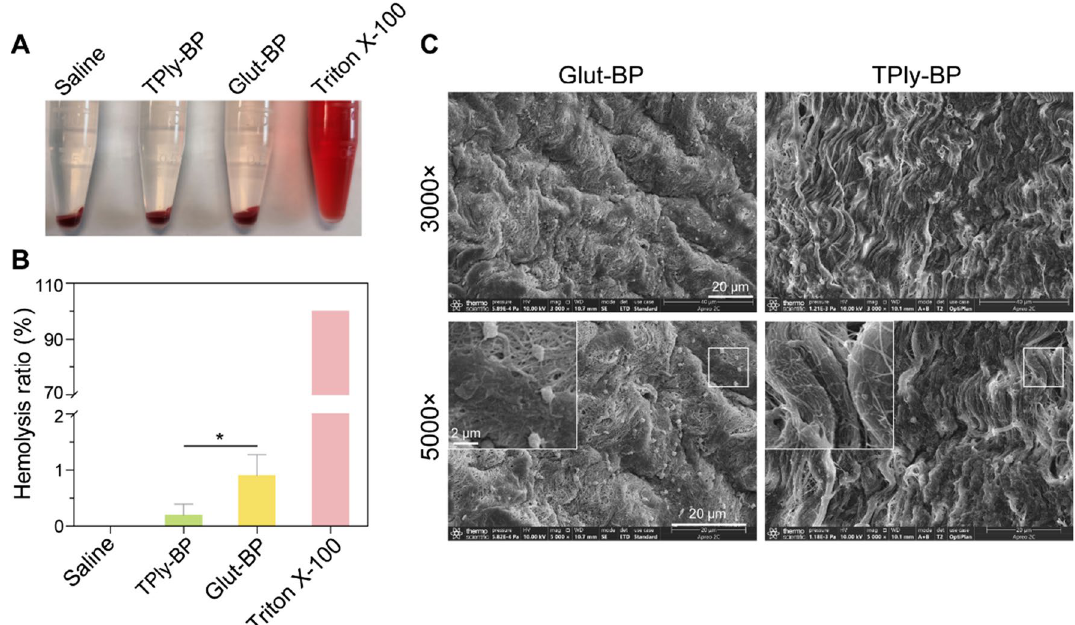
Fig. 5 Blood compatibility study of Glut-BP and TPly-BP. A Photograph of centrifuged red blood cell diluent after incubation with Glut-BP and TPly-BP at 37 °C for 1 h. B The hemolysis ratio of Glut-BP and TPly-BP (n magnifications (3000 , 5000 ) after incubation with PRP for 2 × ×